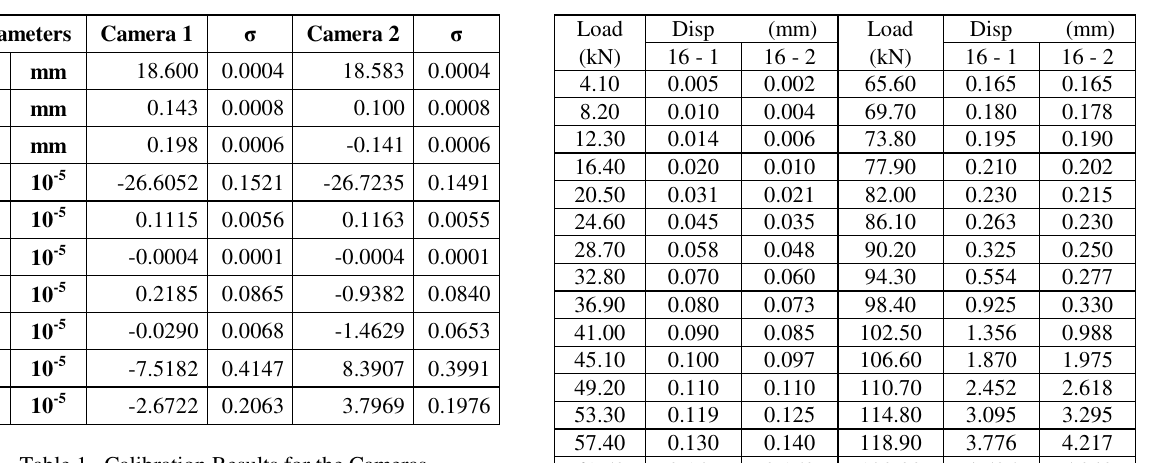
Table 1. Calibration Results for the Cameras